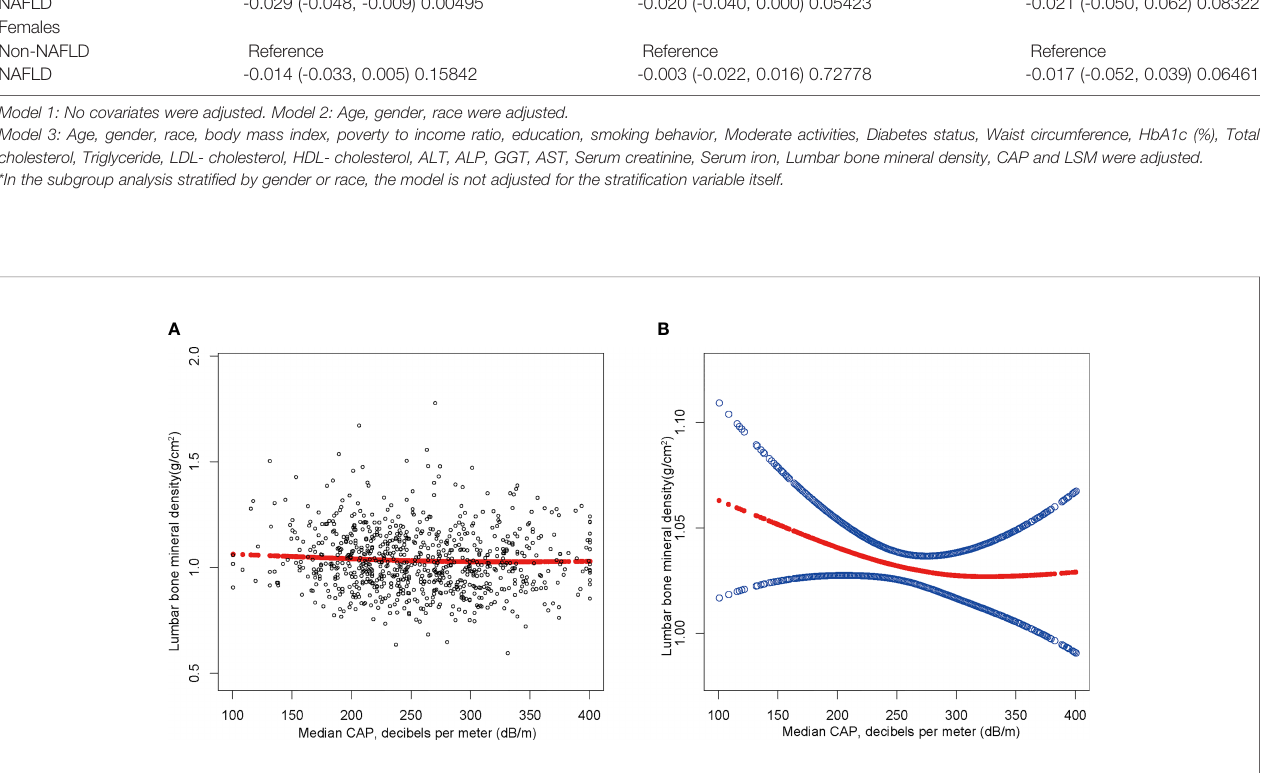
TABLE 3 | Association between NAFLD and lumbar bone mineral density (g/cm2) strati fi ed by race. Race/Ethnicity (%)